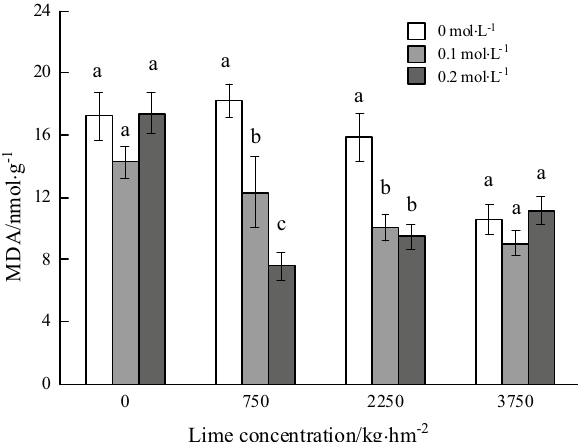
Figure 1. Effects of foliar spraying of oxalic acid on contents of malondialdehyde in roots of Panax notoginseng under Cd stress. Notes The figure legend showed the spray concentration of oxalic acid (mol L −1 ), different lowercase letters indicate significant differences between treatments at the same lime application rate ( P < 0.05). The same